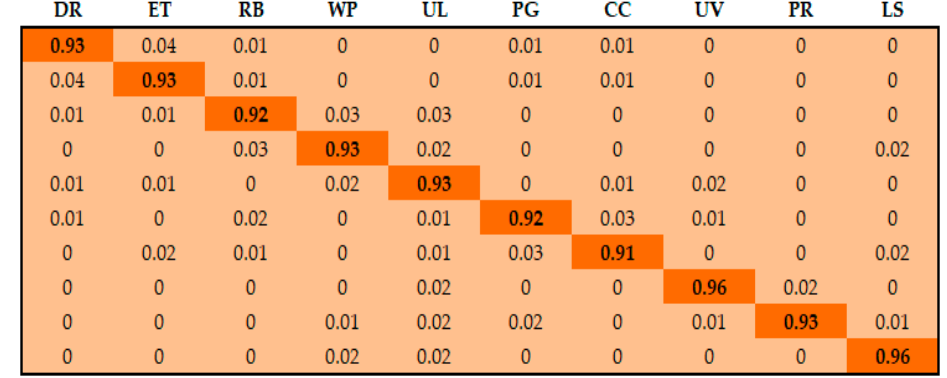
Figure 14. Confusion matrix of MSR Daily Activity 3D dataset, DR = drink, ET = eat, RB = read book, cleaner, PR = play guitar, LS = lay on a